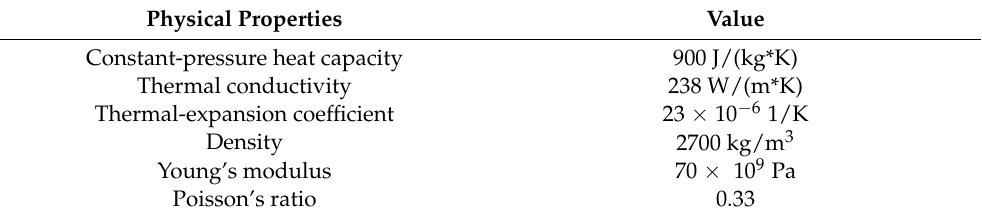
Table 1. Physical-parameter